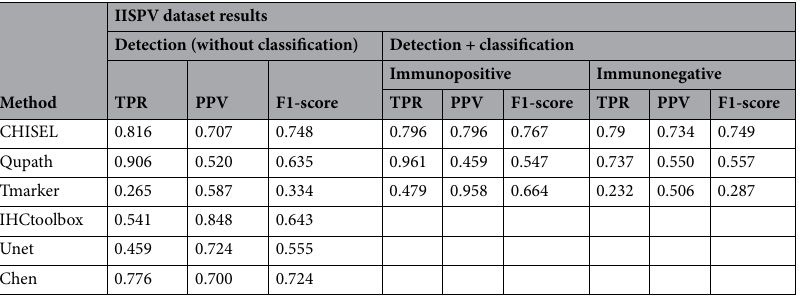
Table 1. The results of detection and detection followed by classification of CHISEL and other state-of-the-art methods based on the processing of the IISPV dataset.